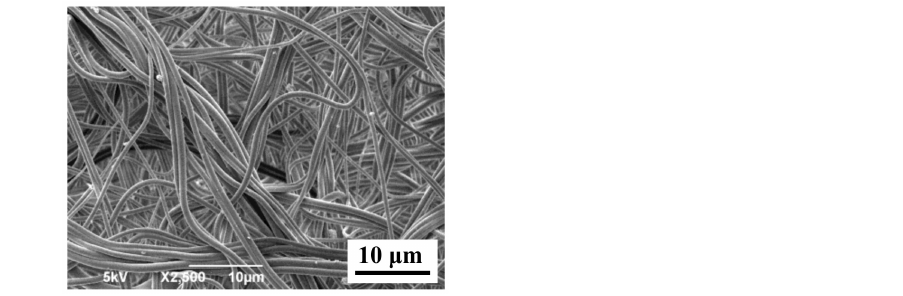
Figure 5. SEM image of Nafion/PEO (99:1) composite NFs after immersion in water for 1 day. The prepared Nafion NF mat exhibited high porosity of 87.3%.